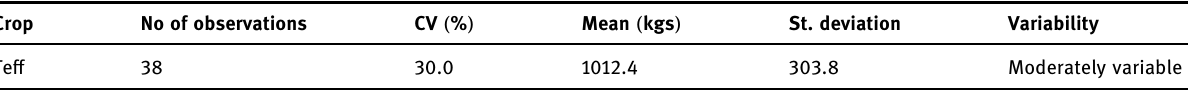
Table 7: CV for te ff yield over the period 1981 – 2018